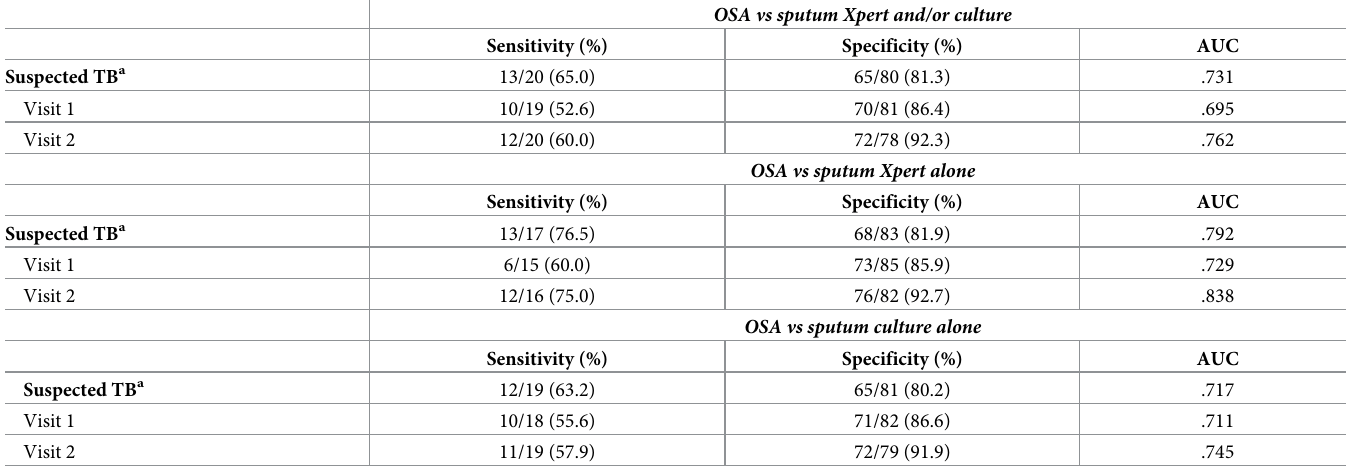
Table 2. OSA diagnostic performance for TB overall and by visit.